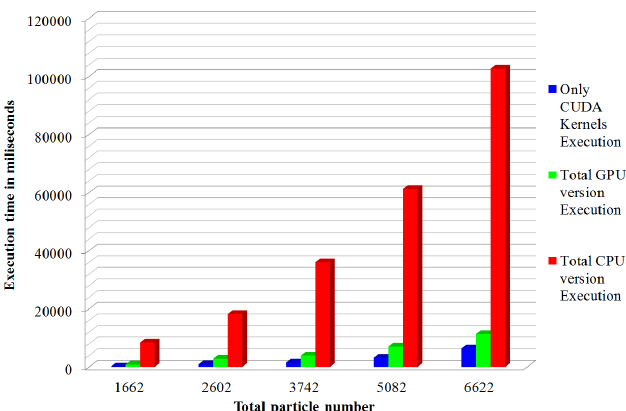
Fig. 13: Execution time versus total particle number in the